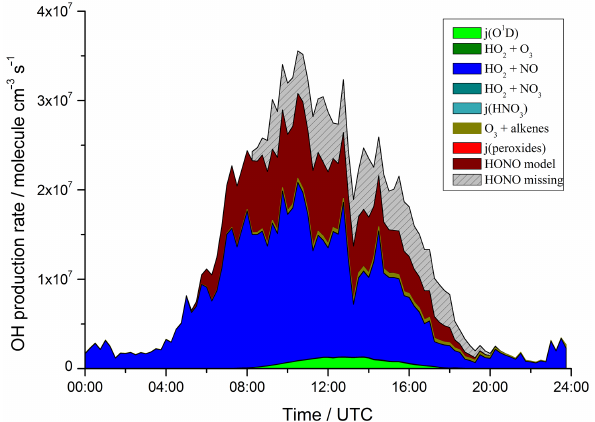
Figure 10. Average diurnal profile of gross OH production rates from different initiation and propagation sources calculated by the model.